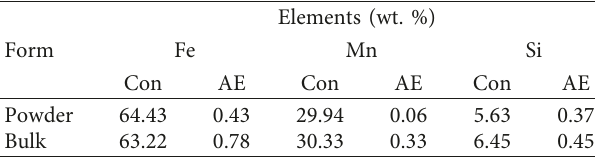
Table 2: XRF analysis results of MA processed powder and sintered